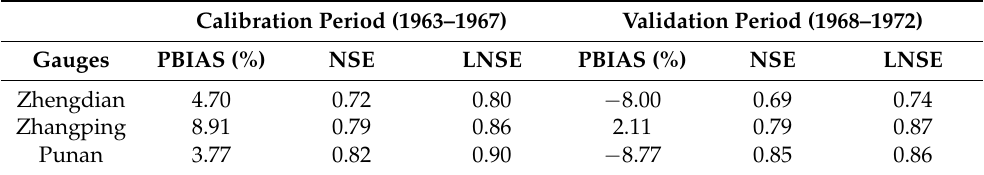
Table 2. Calibration and validation results of GBHM at the Zhengdian, Zhangping and Punan stations. Calibration Period (1963–1967) Validation Period (1968–1972)